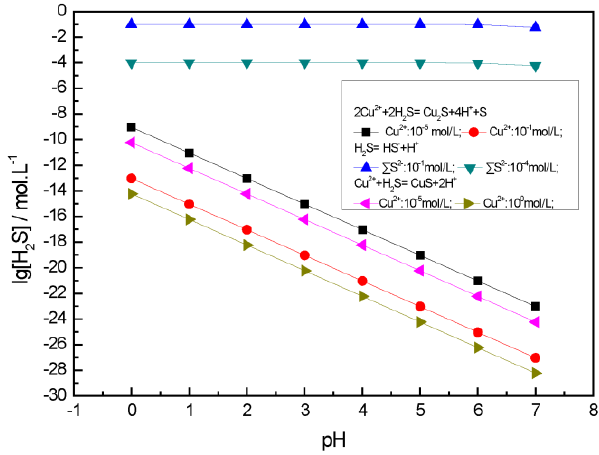
Figure 5. Aqueous H 2 S concentration equilibrated with Cu 2 S and CuS under different Cu 2+ concentrations.